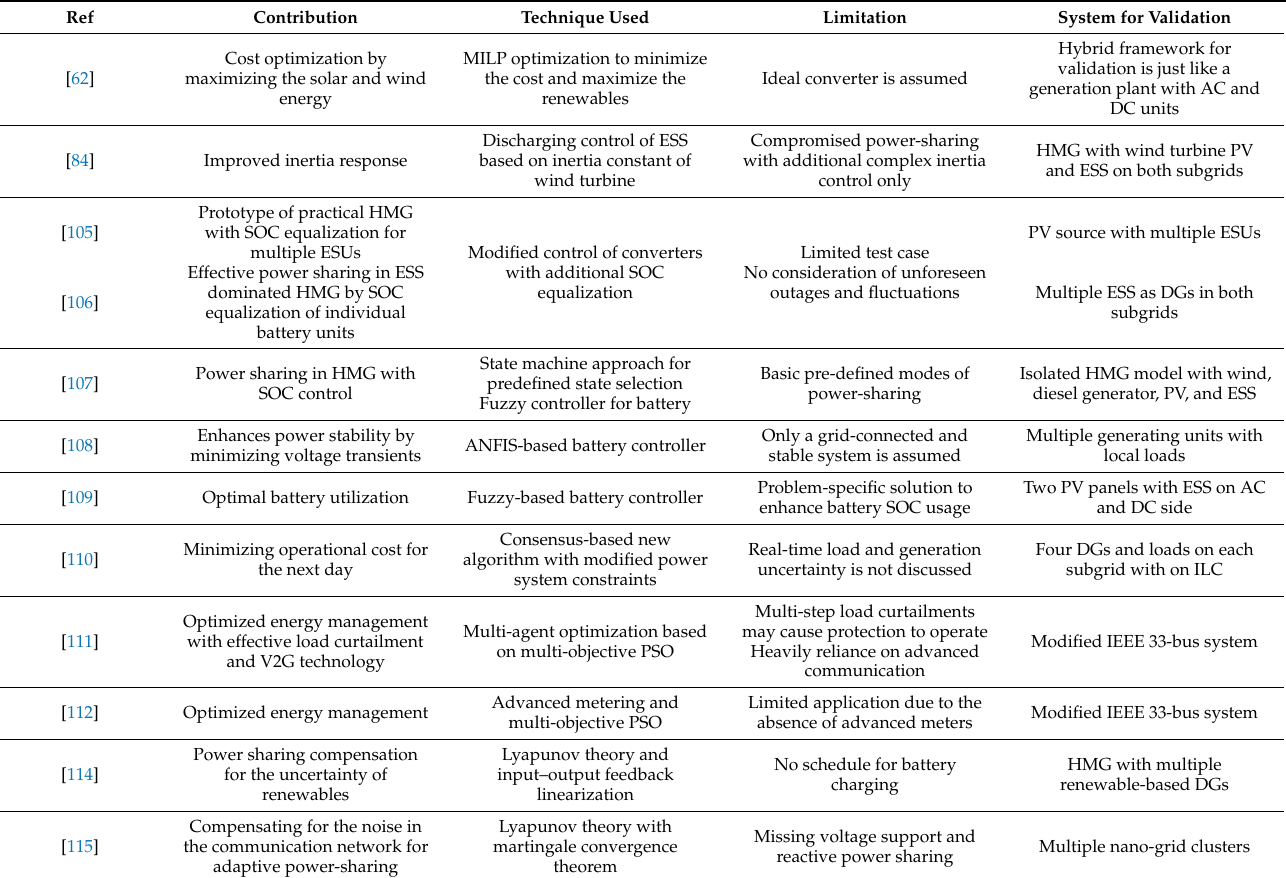
Table 4. Review table for battery management of hybrid microgrid based on ILC